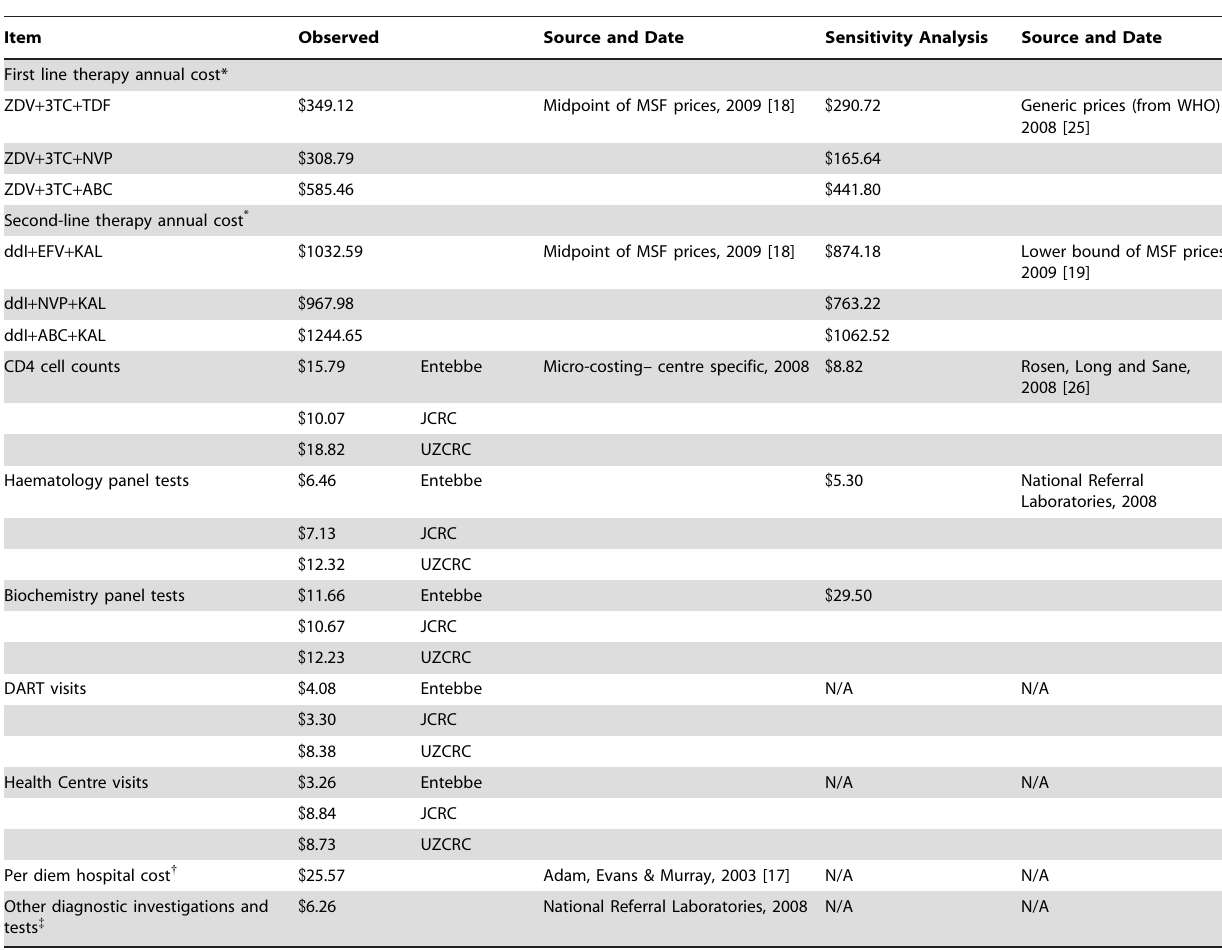
Table 1. Unit costs in 2008 US $